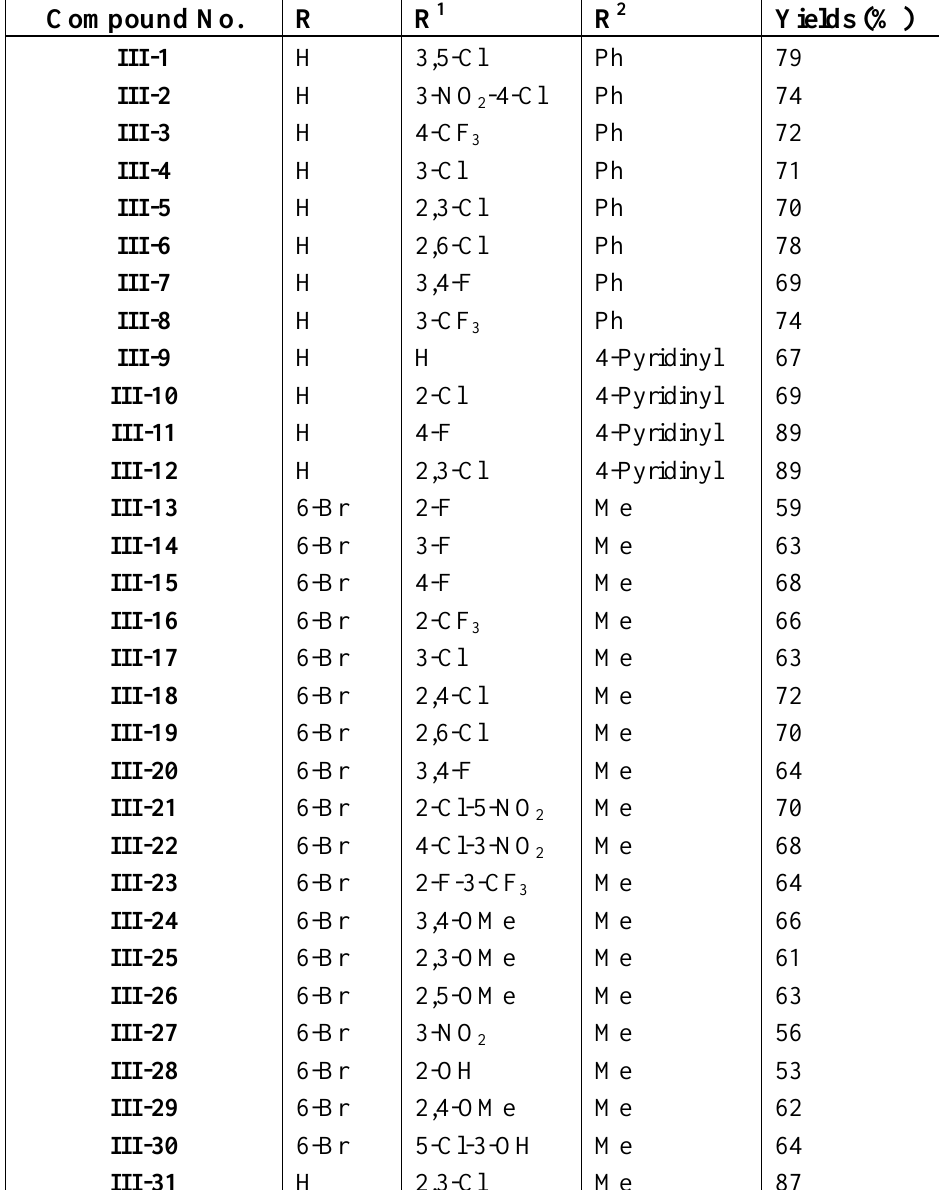
Table 3. Substituents and yields of title compounds III-1-III-31 under optimized conditions. Compound